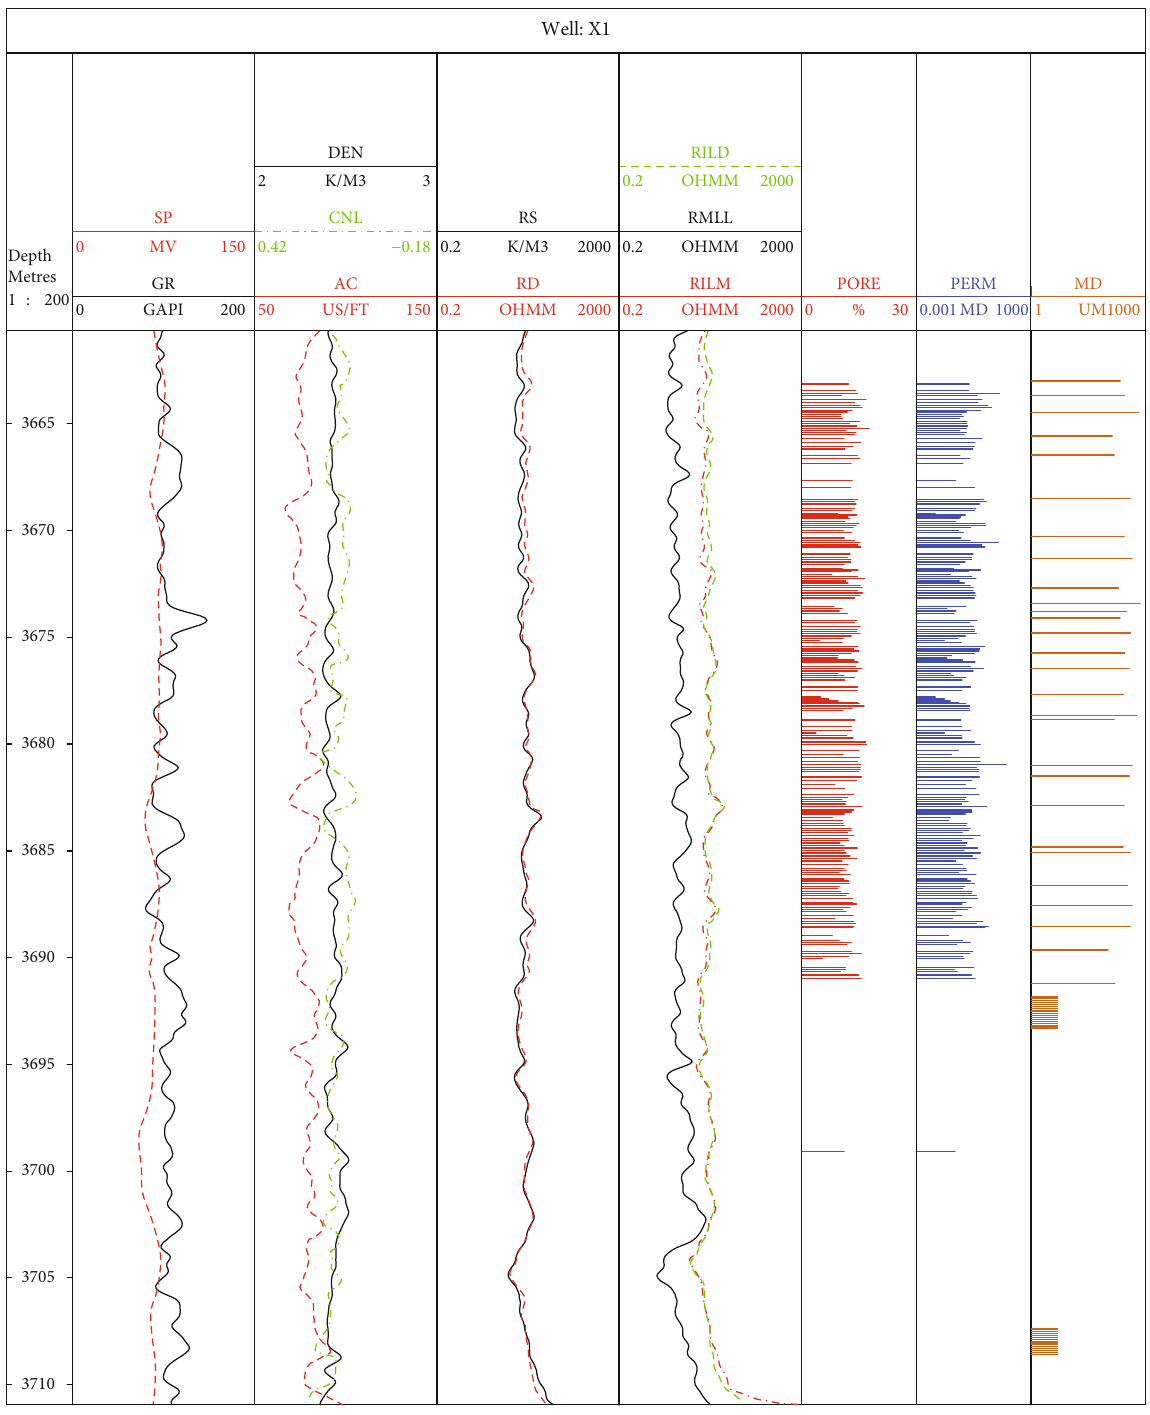
Figure 2: Conventional logging curve and core experiment analysis diagram of S